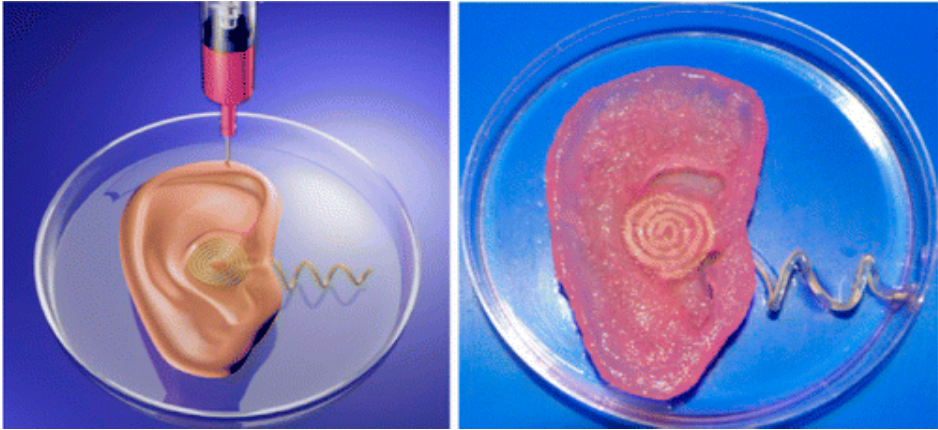
Figure 5. Three-dimensional printed bionic ears [ 80 ] .